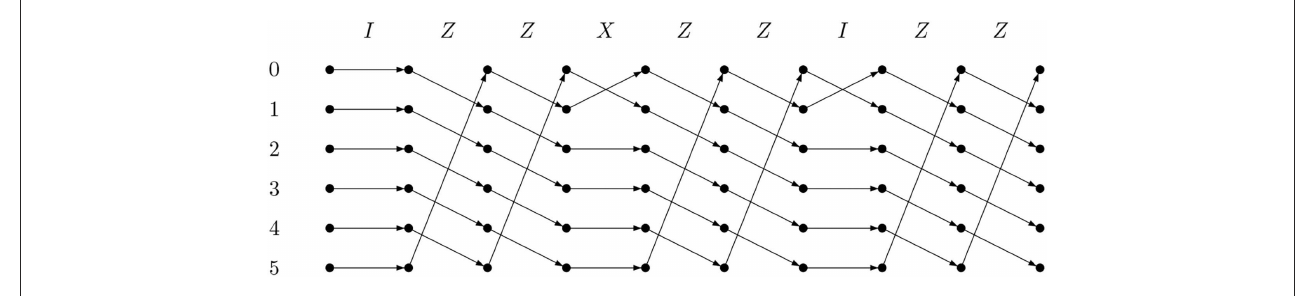
FIGURE6 Word IZZXZZXZZ generates the pair-based permutation h 013254 i